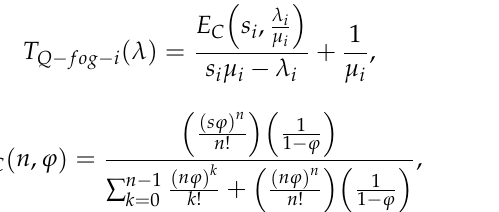
Figure 4. Levels of offloading of the proposed fog-MEC scheme.